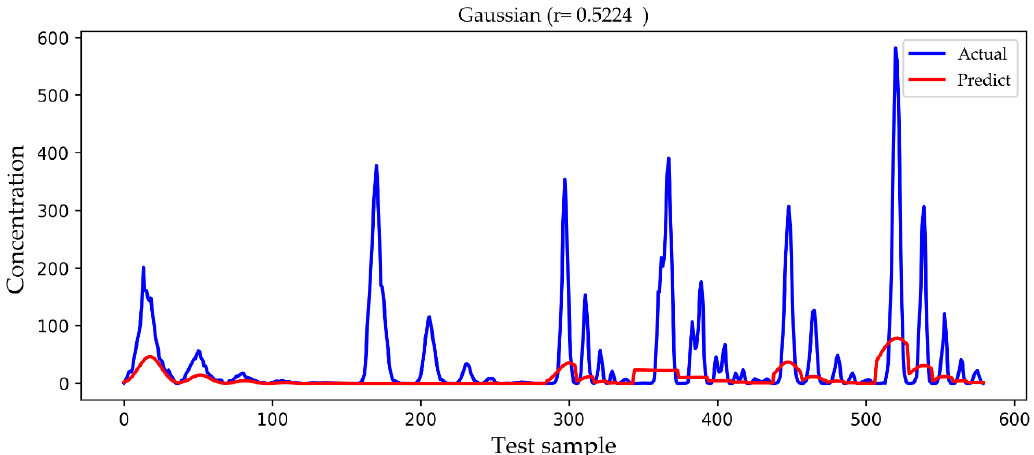
10 of 14 Figure 8. The statistics of 10 experimental results of the BP model and LSTM model. The left-hand side is the RMSE, the middle is the MAE, and the right-hand side is the r . In Figures 9 – 12, we show a comparison of the predicted results and actual concentrations of the four models on the testing set, and the testing set has nearly 600 data points. The Gaussian diffusion model and the SVM model are the results of one experiment, corresponding to Table 2. The BP model and the LSTM model show an experiment that is similar to the average results in Table 2. It is shown in Figure 9 that the Gaussian diffusion model approximation reflects the change process of the gas concentration, and there is no negative concentration value, but the prediction is not accurate at the point of high concentration values. In Figure 10, the SVM model is similar to the Gaussian diffusion model, and the high concentration values are also predicted to be inaccurate, but the trend to be fitted has improved. The bad thing is that there are many negative concentration values in the SVM model, which is not in line with the actual situation, so the overall performance of the SVM model does not surpass that of the Gaussian diffusion model. We can see in Figure 11 that the predicted concentration